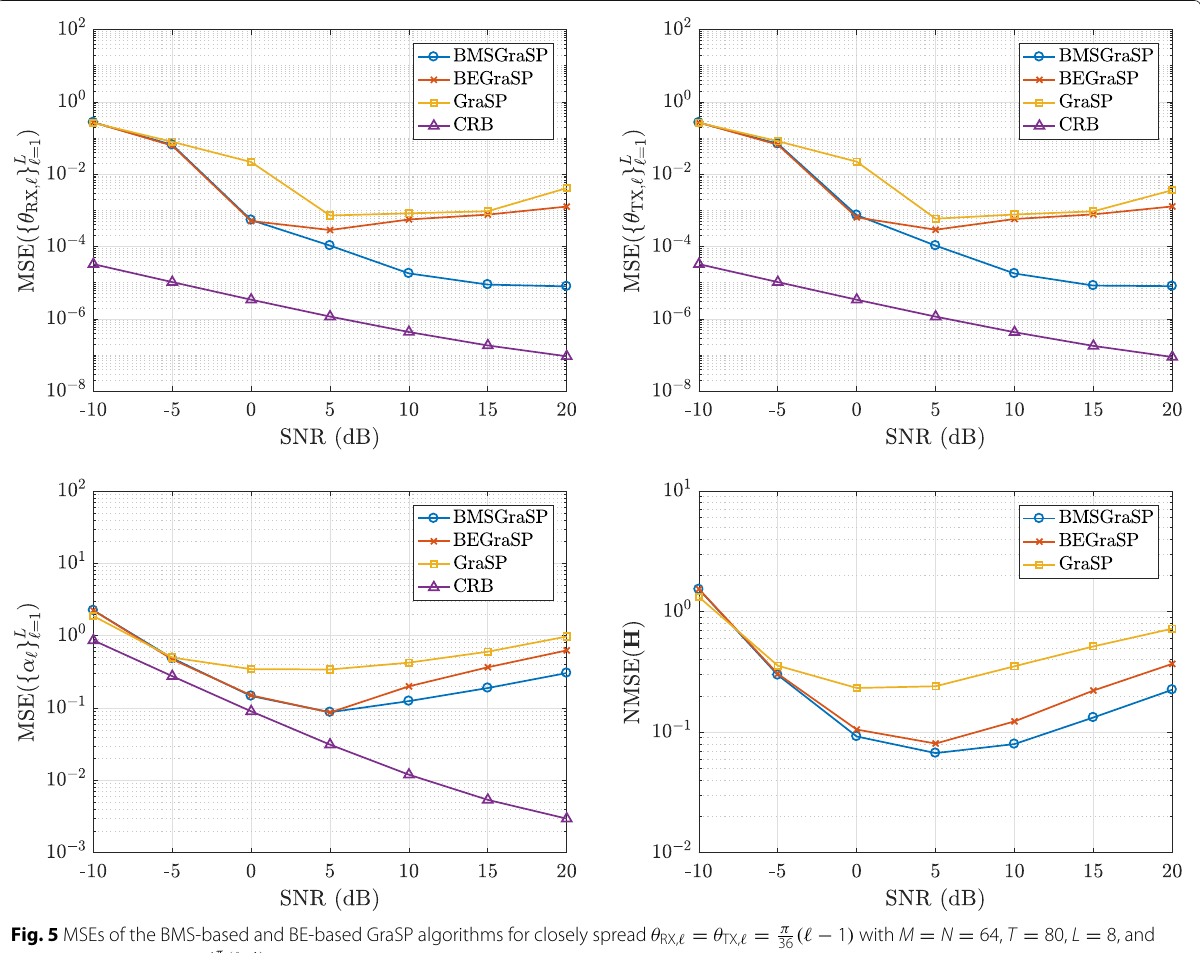
Fig. 5 MSEs of the BMS-based and BE-based GraSP algorithms for closely spread θ RX, (cid:6) = θ TX, (cid:6) = π α (cid:6) = ( 0.8 + 0.1 ((cid:6) − 1 )) e j π 4 ((cid:6) − 1 ) . The CRB is provided as a reference, which was derived in [36]